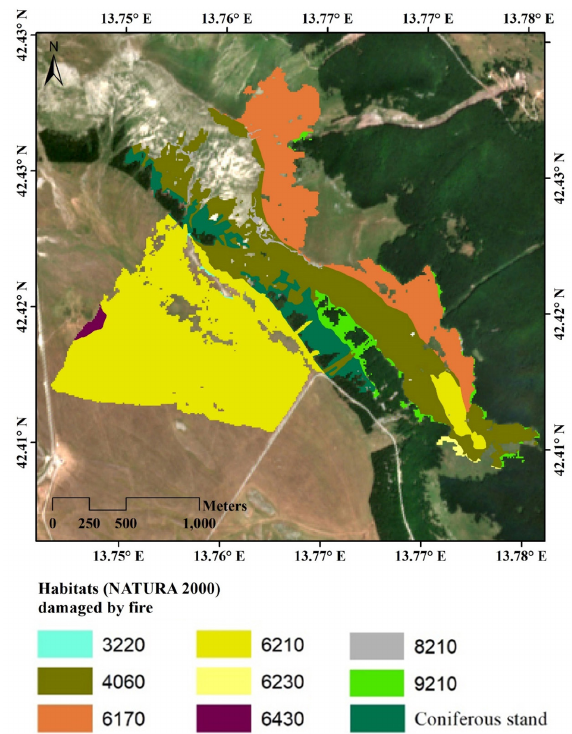
Figure 3. Annex I Habitats burned by the fire of 2017 in the study area. The numerical codes refer to the nomenclature used to identify the Annex I habitats (http://vnr.unipg.it/habitat/, see also Table